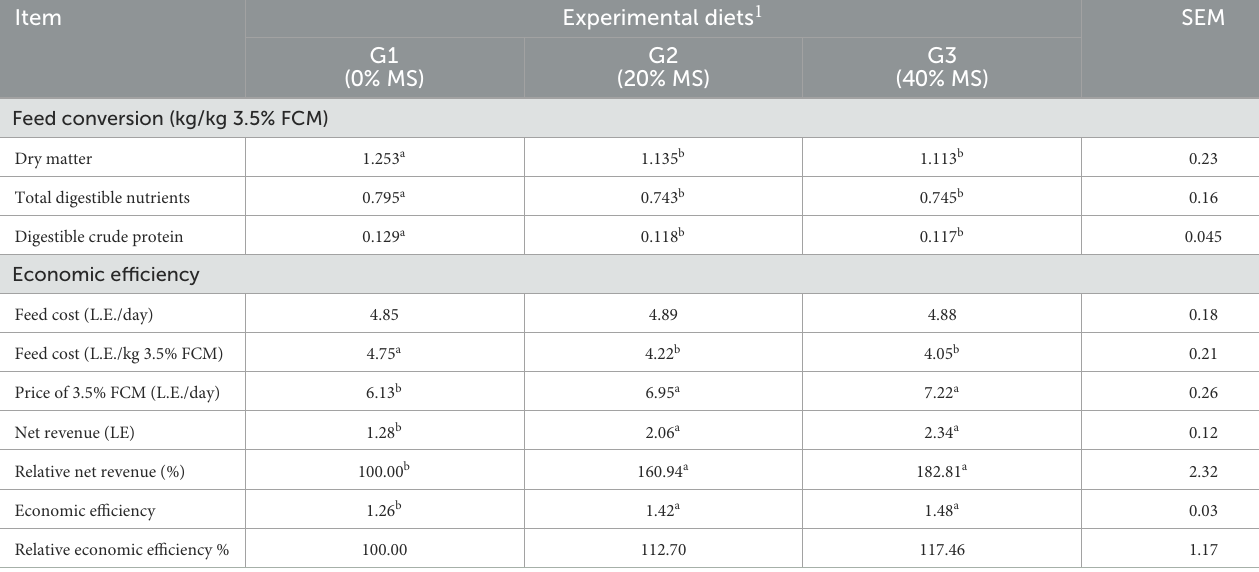
TABLE 6 Feed conversion and economic feed efficiency of experimental diets fed by female kids in different groups.